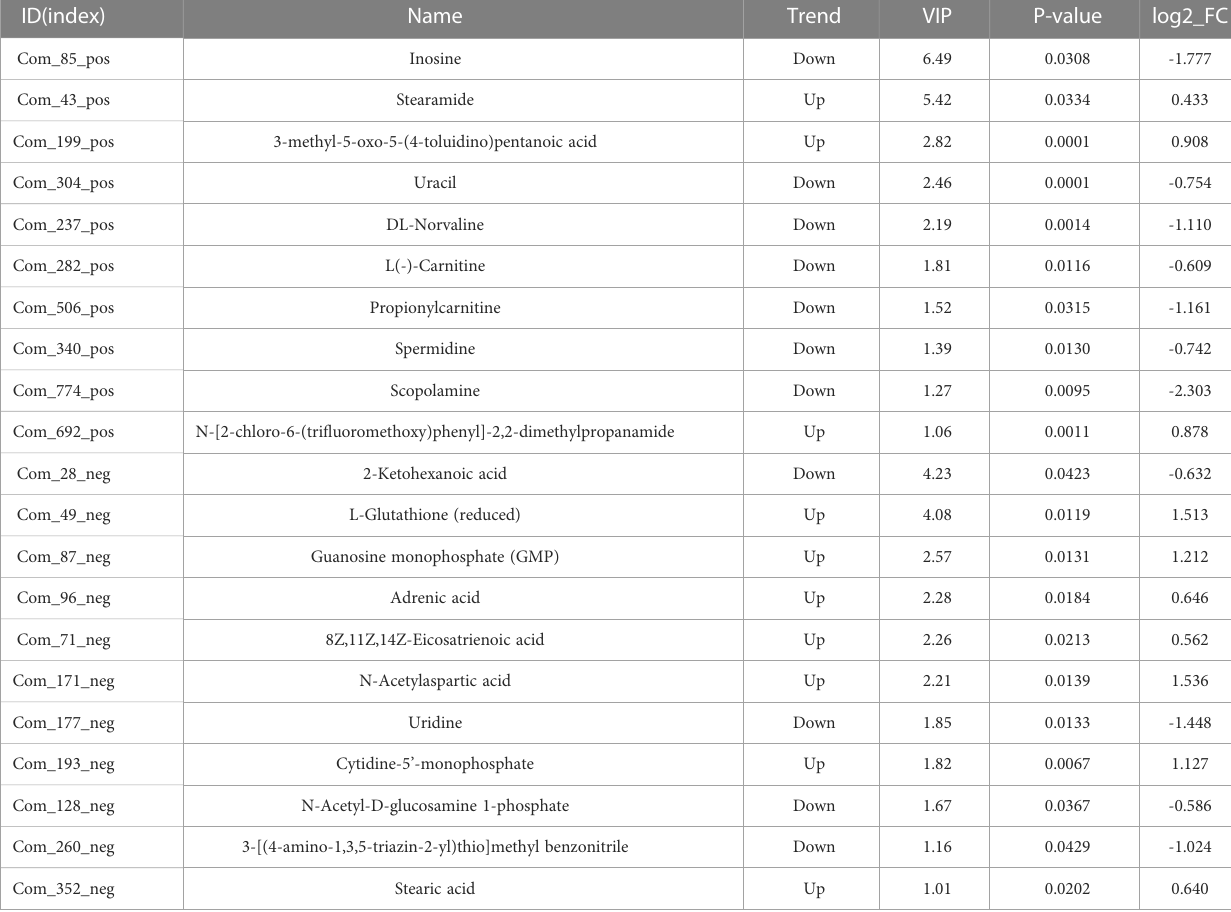
TABLE 1 Differential metabolites in the intestine of juvenile Trachinotus ovatus under low-temperature stress.